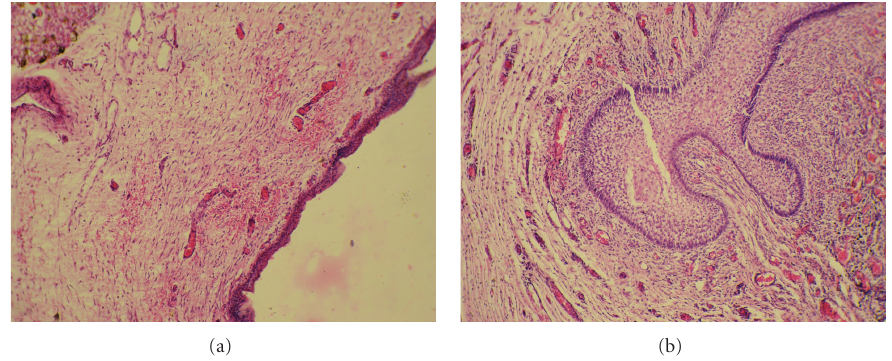
Figure 2: Microscopic findings. (a) Histologic section from the anterior abdominal wall showing normal skin and absence of skeletal muscle. (b) Transverse sections from the penis showing noncanalised urethra with islands of transitional epithelium and squamous metaplasia.